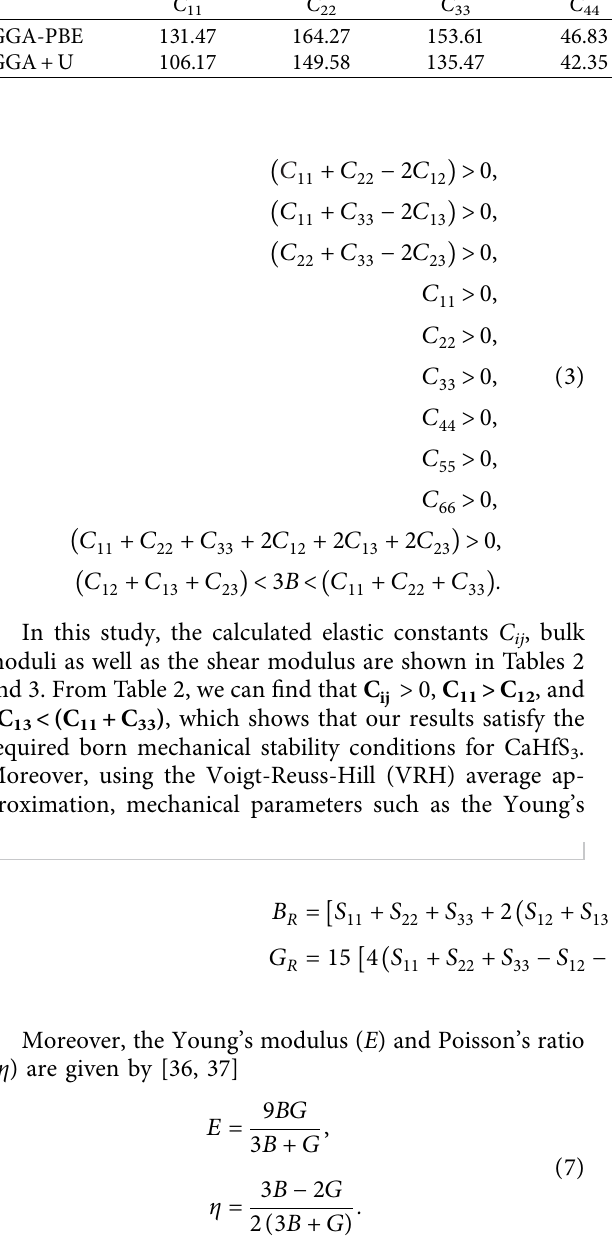
Table 2: Calculated elastic constants of CaHfS